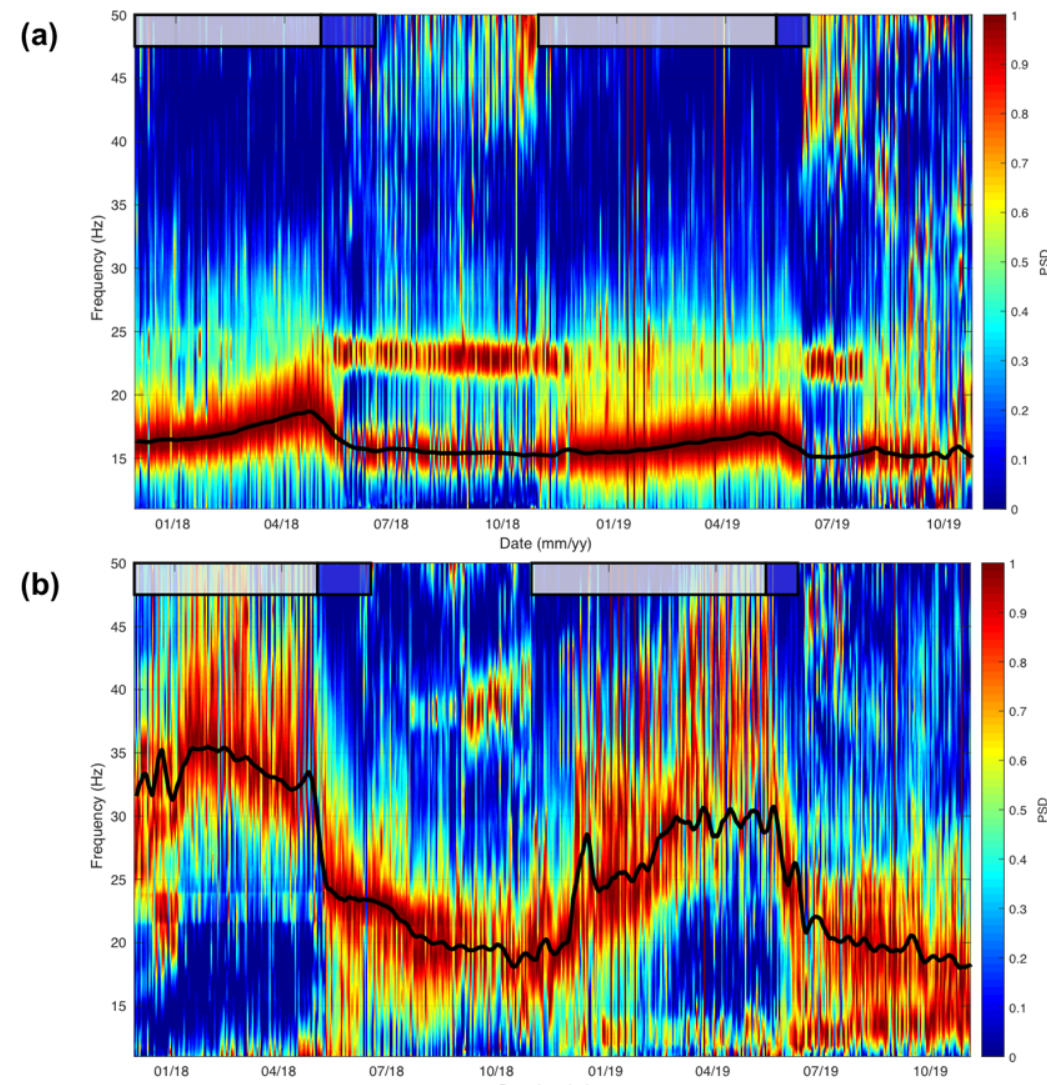
Figure 3. Normalized power spectra density (PSD) from hourly spectrograms of the passive seismic recordings of Laurichard site, from (a) C00 seismometer and (b) C05 seismometer. The bold black line denotes the moving-window average of hourly spectrogram maxima. Snow cover and melting periods are depicted by grey and blue boxes,